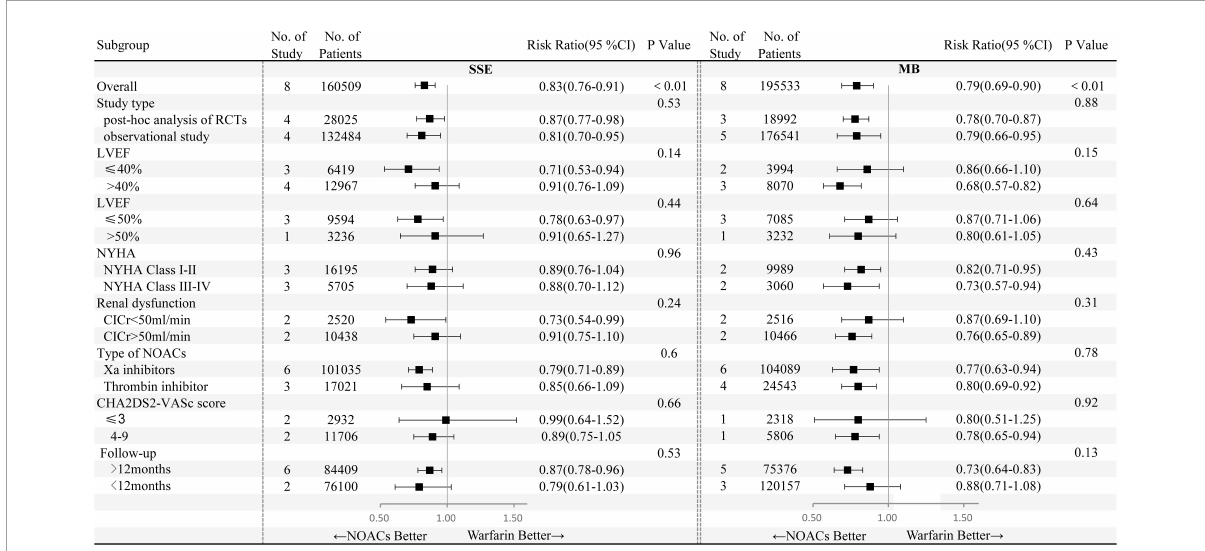
FIGURE2 Primary effectiveness and safety outcomes of non-vitamin K antagonist oral anticoagulants (NOACs) versus warfarin according to different subgroups. NYHA, New York Heart Association; ClCr, creatinine clearance; CI, confidence